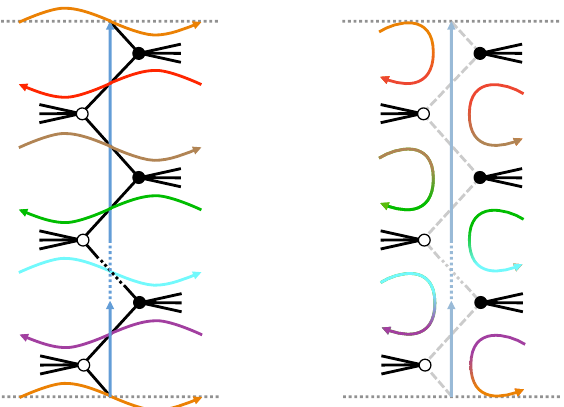
Figure 3. Left: local piece of the mirror Riemann surface around the 1-cycle wrapped by a D2- brane instanton (blue), consisting of 2 k edges. The top and bottom dotted lines are identi(cid:12)ed. The collections of half edges sticking out of each node represent general superpotential couplings. The orange, brown and cyan, and the red, green and purple arrowed lines are pieces of additional zig-zag paths that correspond to D6-branes intersecting the D2-brane instanton, with positive or negative intersection numbers, respectively. Right: the D2-brane instanton has backreacted, so the blue line has disappeared. D6-brane paths have been cut at their intersection with the former D2- brane instanton cycle, and recombined. The black nodes and the white nodes should be regarded as recombined into a single black and a single white node,